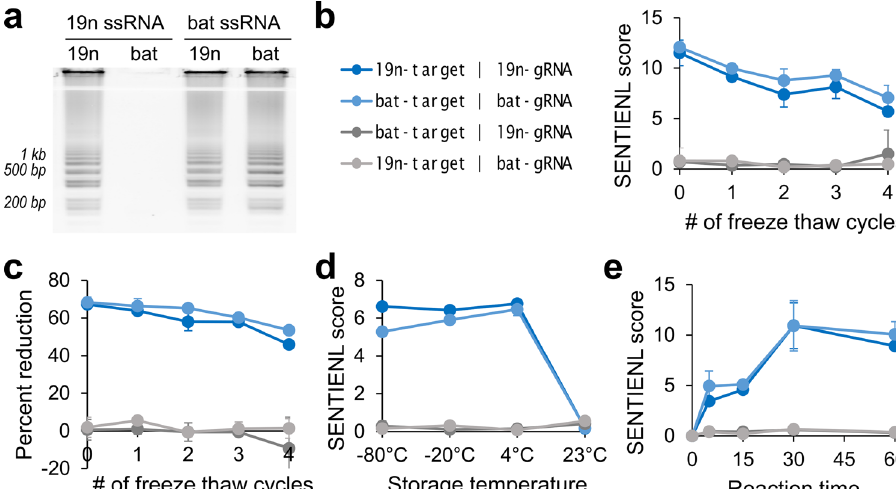
Fig. 3 Reagent stability, reaction duration, and distinguishing between related sequences. a Result of isothermal ampli fi cation (RT-LAMP) alone for nucleic acid detection. Agarose gel of RT-LAMP product with use of either SARS-CoV-2 (19n) or bat-SL-CoVZC45 (bat) RT-LAMP primers for detection of 19n ssRNA or bat ssRNA, respectively. Notably, detection for SARS-CoV-2 (using 19n RT-LAMP primers) resulted in a false positive when bat ssRNA was in the sample. b and c Stability of SENTINEL master mix to freeze – thaw cycles, measured with ( b ) SENTINEL scores or with ( c ) percent reduction in DNA concentrations with use of the on-target versus non-targeting gRNA. The legend is the same for panels ( b ) – ( e ): 19n-target and bat-target indicate SARS- CoV-2 and bat-SL-CoVZC45 ssRNA samples, respectively, while 19n-gRNA and bat-gRNA indicate Cas9/gRNA targeting SARS-CoV-2 and bat-SL- CoVZC45 sequences, respectively. d Stability of SENTINEL master mix to 1-month storage in − 80, − 20, 4, or 23 °C (room temperature). The master mix only loses activity after 1-month storage in room temperature. e SENTINEL score as a function of room temperature reaction time. b – e All error bars represent ±1 standard deviation from mean, from three experimental